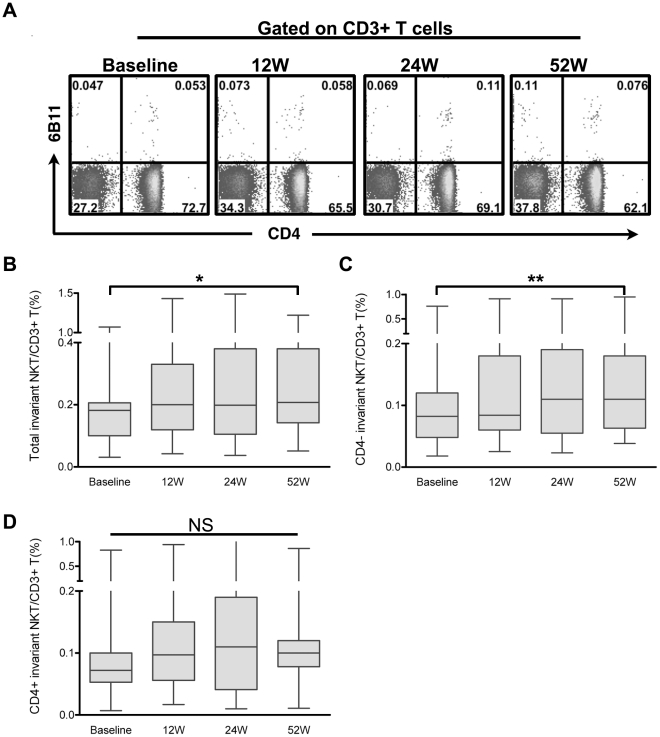
Circulating iNKT cells of CHB patients were recovered during antiviral therapy.(A) Representative dot plots. (B–D) Pooled data showing the dynamic changes of total, CD4− and CD4-iNKT cells at different time points in CHB patients (n = 19) during antiviral therapy. * P<0.05, ** P<0.01, using repeated measures ANOVA followed by Tukey's Multiple Comparison Test; NS, no significance.